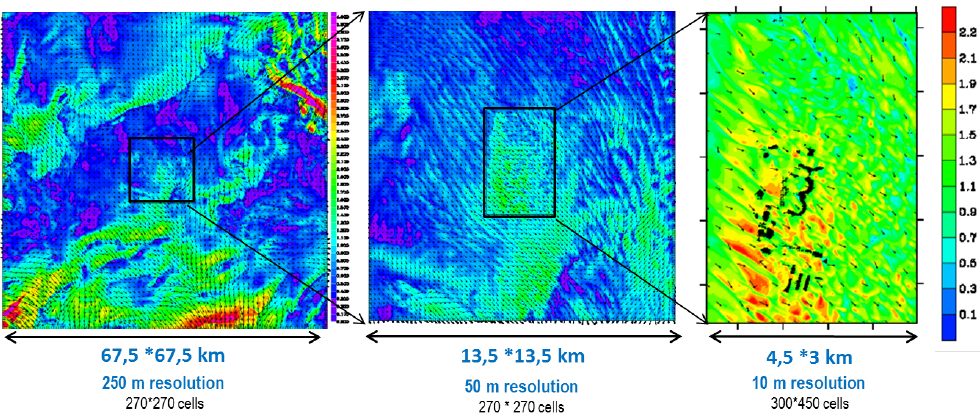
Figure 3. Simulated wind modules and direction over the three domains of simulation 2 m above ground (the first level of simulation), at 7:00